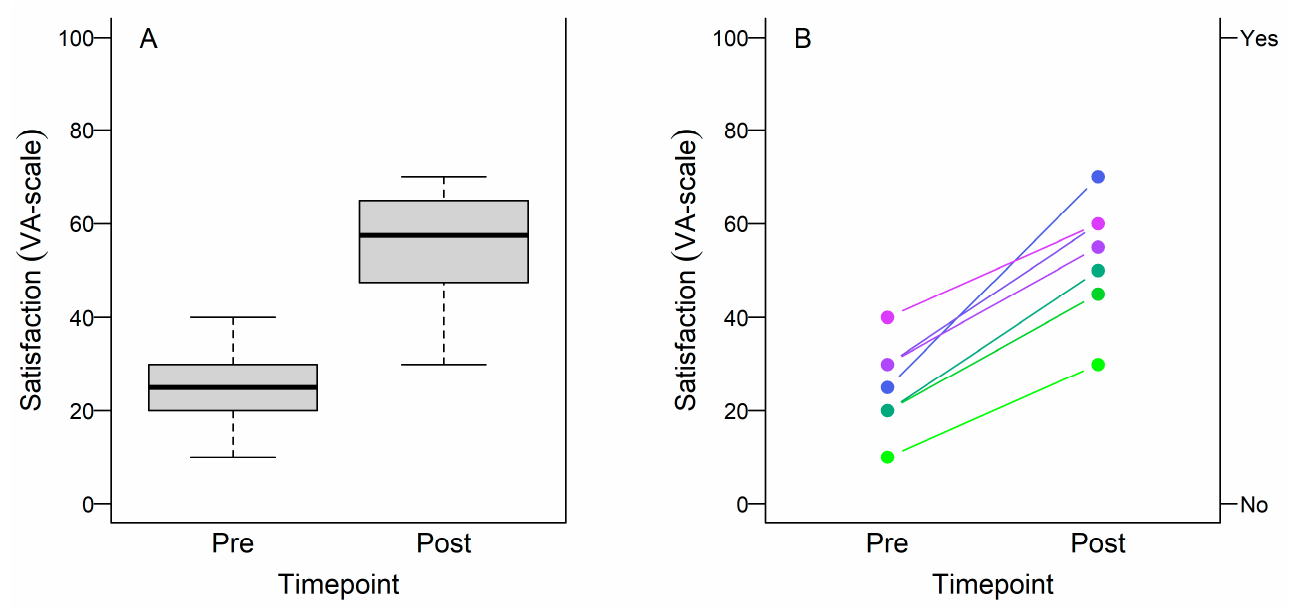
Figure 3. Panel A ( left ): Boxplots over the sample’s voice satisfaction rating (on a Visual Analog scale) before ( pre ) and after ( post ) training. Panel B ( right ): Individual treatment “trajectories”. Each participant’s pre and post measure is color-coded per participant and illustrated with a circle connected by a straight line. Anchors are illustrated in the right-hand panel of Panel B as 0 = No and 100 = Yes. Table 3. Each individual’s voice satisfaction rating (on a Visual Analog scale) before ( pre ) and after ( post ) treatment. The right-most column is the post minus pre difference in VA-scale units. Further illustrated are the mean and standard deviation for each column. Because the inter-individual variation in the difference scores is sufficiently small, a t -test applied to the mean difference is statistically significant. t 7 = 8.5, p < 0.0001. The standardized mean difference, Cohen’s d , is 3.0. Participant Pre (VA-Scale) Post (VA-Scale) Diff (VA-Scale) A